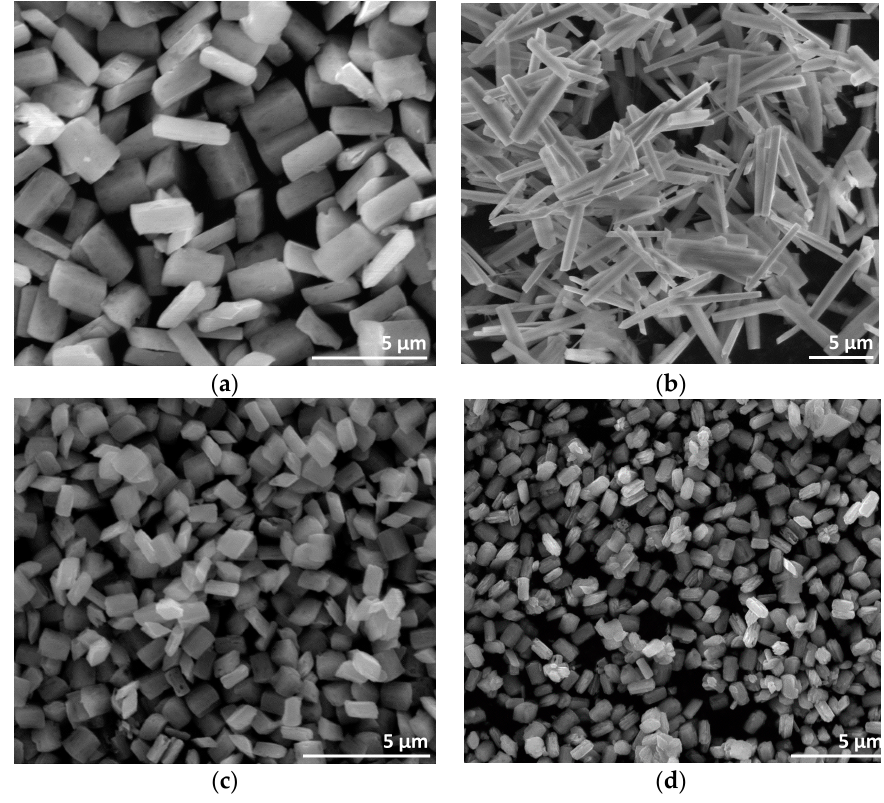
Figure 4. SEM images of gallium oxide nanoplates synthesized using CTAB with different